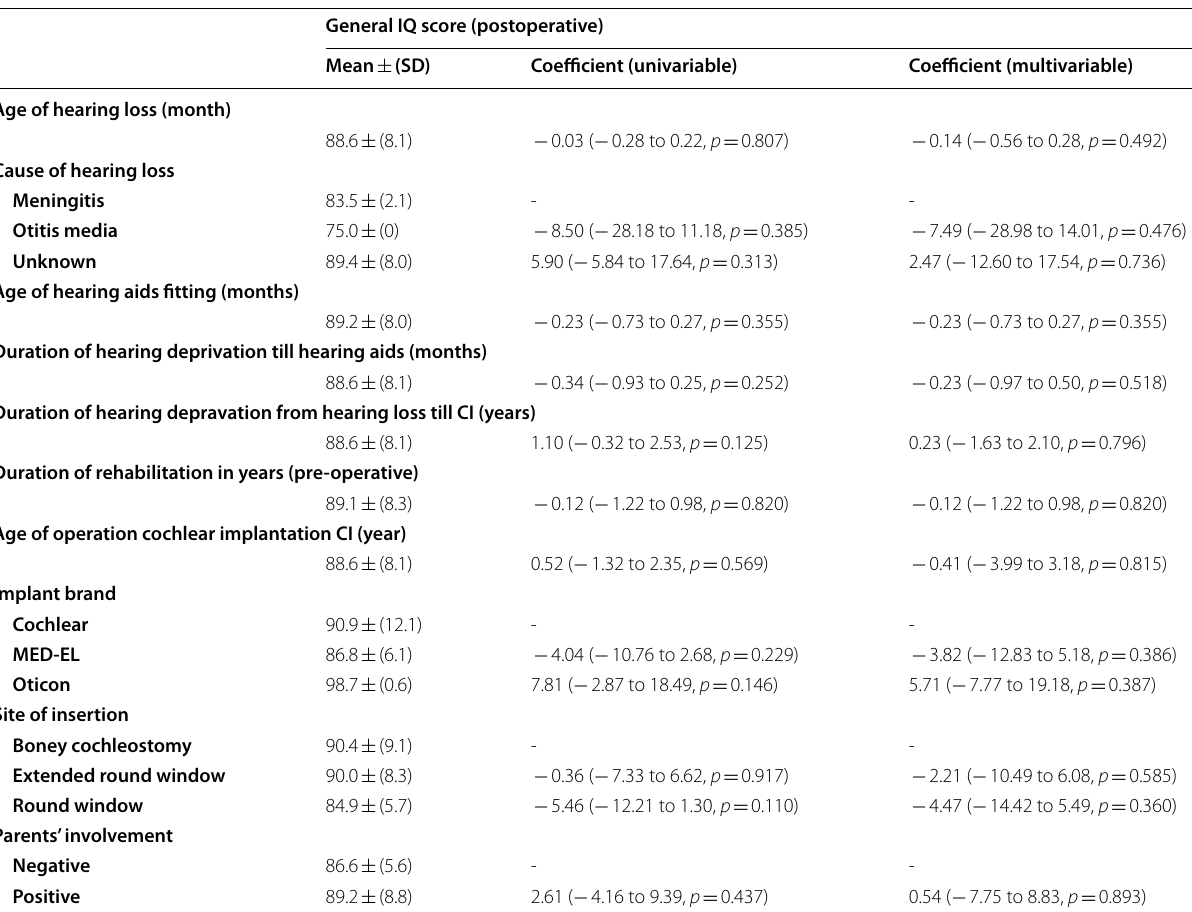
Table 4 Multivariate linear regression of general IQ score